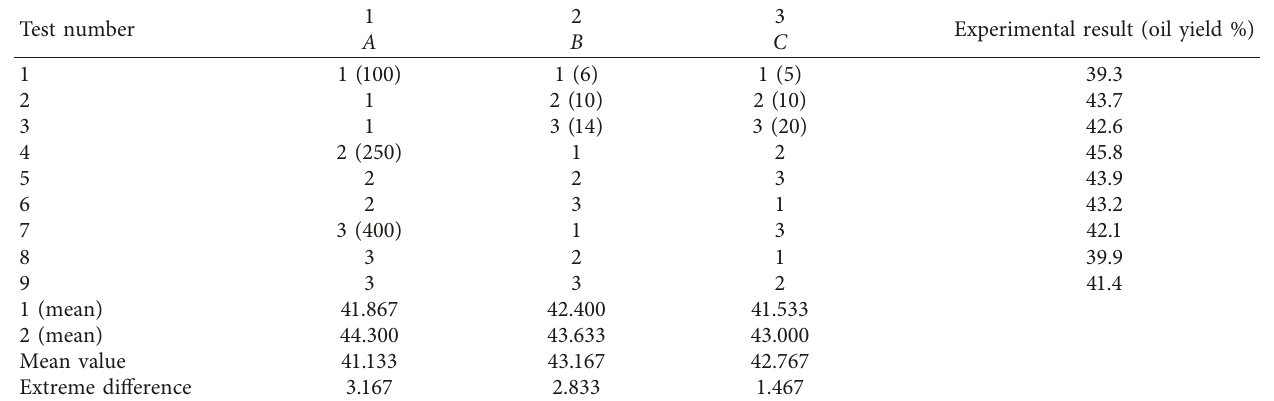
Table 2: Results of orthogonal pyrolysis experiment